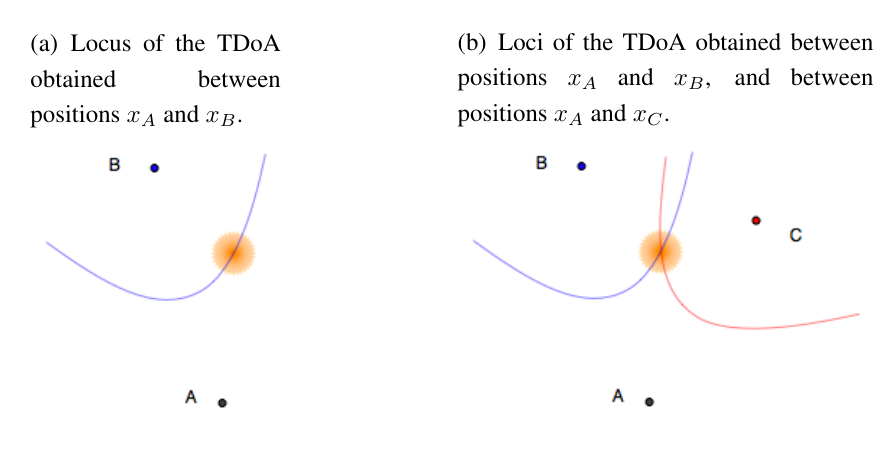
Figure 3. Hyperbolic multilateration of an acoustic